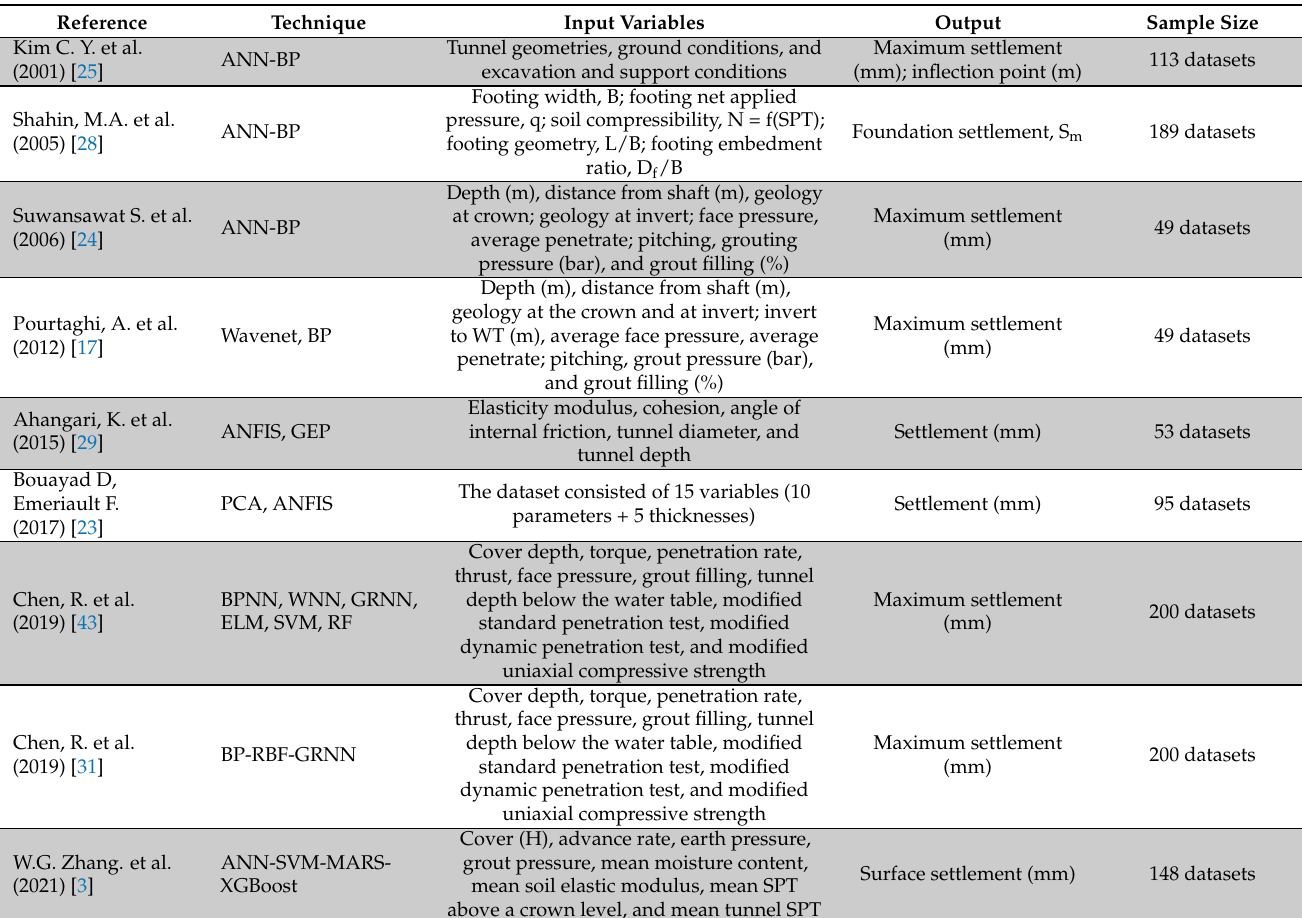
Table 1. Summary of works on settlement prediction utilizing methods based on soft